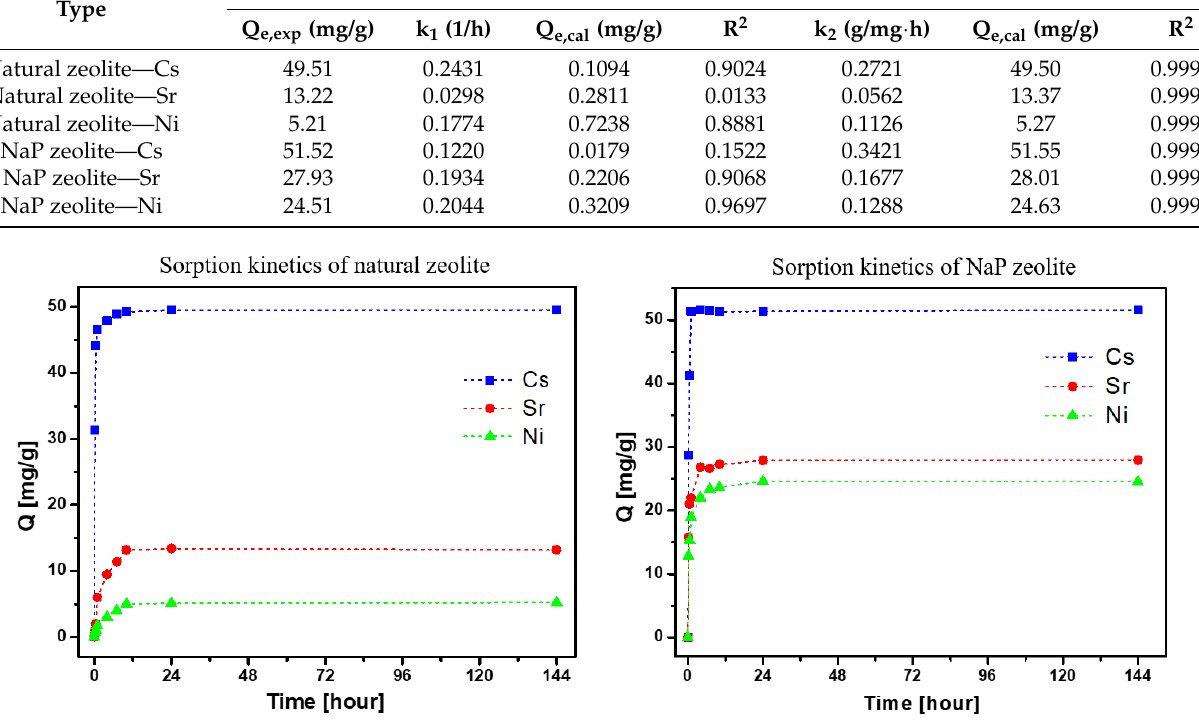
Figure 5. Adsorption kinetics for the removal of Cs, Sr, and Ni by natural zeolite and NaP zeolite. The adsorption isotherms for the removal of Cs, Sr, and Ni on natural zeolite and